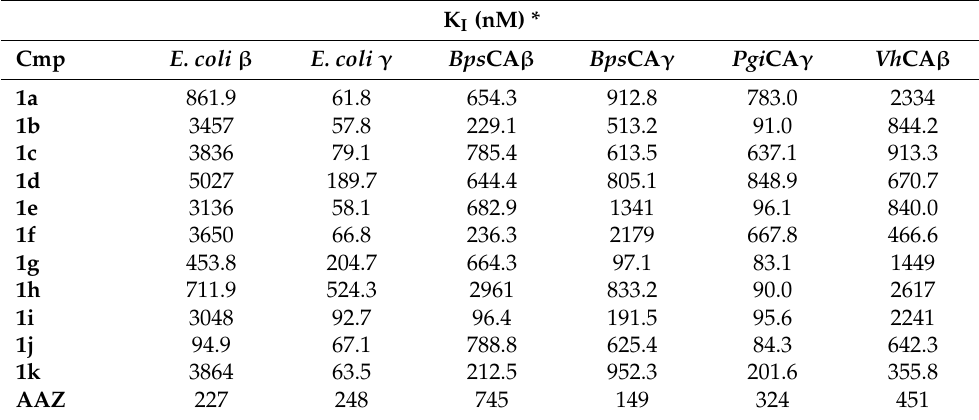
Table 3. Inhibition data against different β - and γ -CA isoforms from E. coli , BpsCA , PgiCA, and VhCA for the labeled compounds and AAZ by a stopped-flow CO 2 hydrase